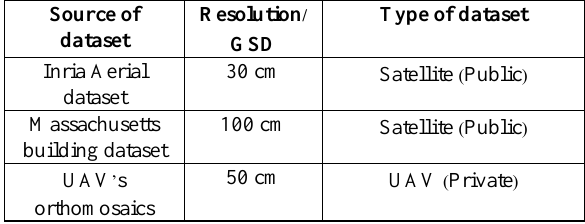
Table 2 . 1 : Sources of dataset and GSD ( Ground Sampling